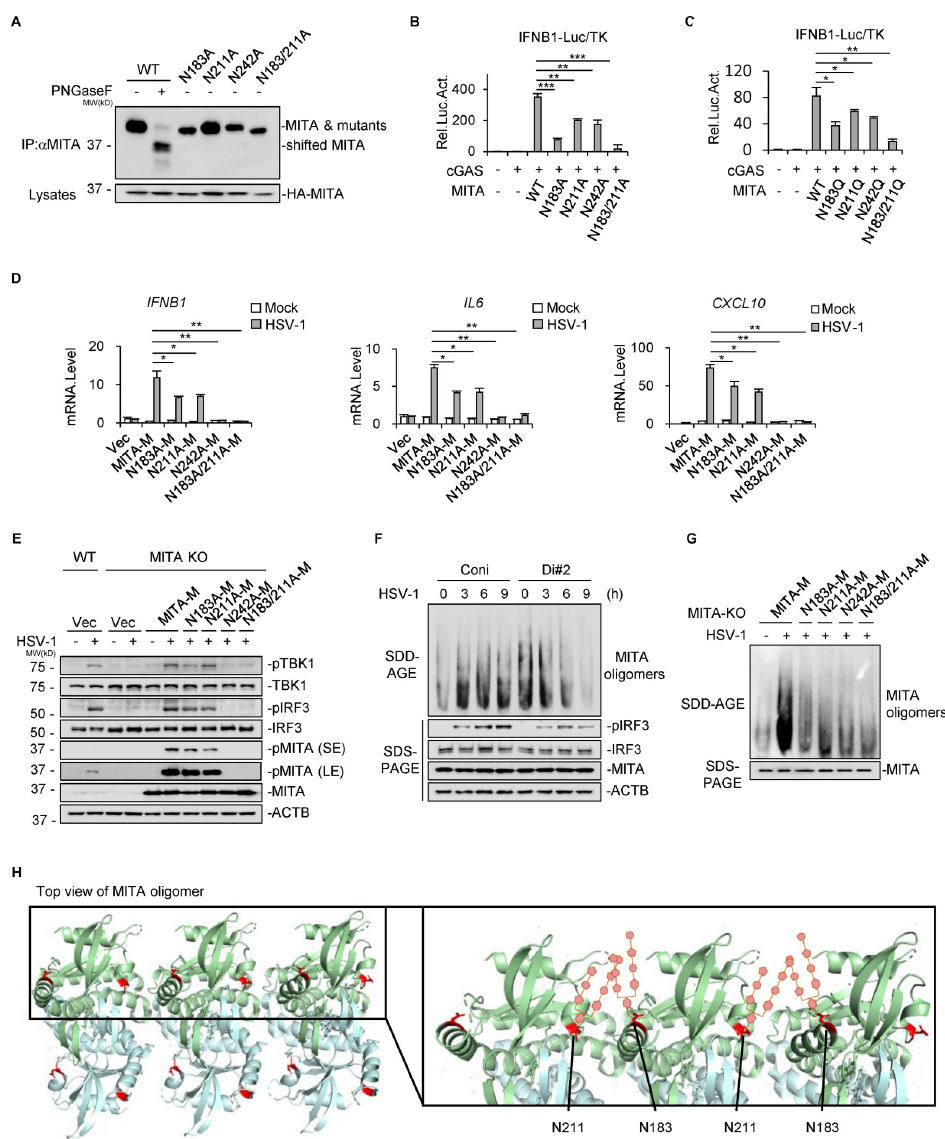
Fig 5. N-glycosylation of MITA at N183 and N211 is critical for its oligomerization. (A) HA-MITA (WT) or its Asn-to-Ala mutants were transfected into HEK293T cells and digested with or without PNGase F as indicated, followed by SDS–PAGE using 15% gel and immunoblotting analysis. (B, C) HA-MITA or its Asn-to-Ala mutants (B) or Asn-to-Gln mutants (C) were cotransfected with HA-cGAS and dual luciferase reporters into HEK293T cells. The activation of the IFNB1 reporter gene was measured 24 hours later. Data displayed are the mean ± SD (n = 3). � P < 0.05, �� P < 0.01, ��� P < 0.001 (unpaired t test). (D, E) Stable MITA-deficient HaCaT cells were established by transducing specific MITA gRNA. Cells were then reconstituted by transfecting CRISPR-resistant MITA mutants, including full-length MITA (MITA-M) or Asn-to-Ala mutants. Empty vector was also transfected as a control (Vec). Cells were infected with HSV-1 (MOI = 2) for 6 hours and subjected to qPCR (D) and immunoblotting analysis (E). One representative result from at least two independent experiments is shown (E). Data displayed are the mean ± SD (n = 3). � P < 0.05, �� P < 0.01, ��� P < 0.001 (unpaired t test). SE: short exposure; LE: long exposure. (F) DDOST knockdown THP-1 cells and control cells were infected with HSV-1 (MOI = 2) for the indicated time before SDD– AGE (upper panel) and SDS–PAGE (lower panel) analysis. One representative result from at least three independent experiments is shown. (G) Reconstituted HaCaT cells with MITA-M or its Asn-to-Ala mutants were infected with HSV-1 (MOI = 2) for 3 hours, followed by SDD–AGE (upper panel) or SDS–PAGE (lower panel). One representative result from at least three independent experiments is shown. (H) N-glycosylation residues are displayed in the structure of the MITA oligomer (PDB: